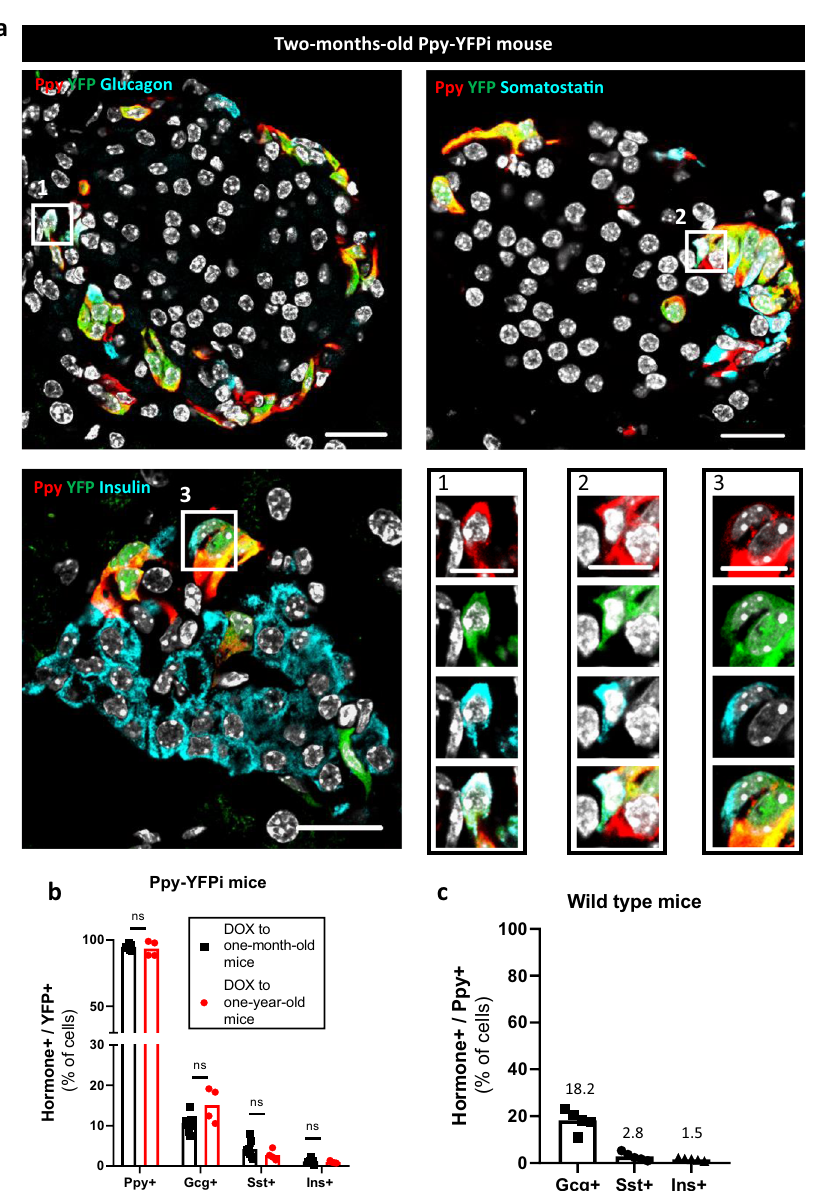
Fig. 3 Bihormonal islet cells co-express Ppy and another hormone in adult mice. a Immuno fl uorescence on pancreatic sections from 2-months-old Ppy- YFPi mice stained with Ppy (red) and YFP (green) in combination with: Glucagon (cyan, top left), Somatostatin (cyan, top right) or Insulin (cyan, bottom left). Bihormonal Ppy-Gcg (1), Ppy-Sst (2) and Ppy-Ins (3) cells are detected (bottom right). Scale bars: 20 μ m or 10 μ m (insets 1, 2, 3). b In young Ppy-YFPi mice ( n = 8 mice), 94.6%, 10.7%, 4.22% and 1.16% of YFP-traced cells are Ppy + , Gcg + , Sst + and Ins + , respectively (5411 YFP + Ppy + , 610 YFP + Gcg + , 225 YFP + Sst + and 81 YFP + Ins + out of 5714 YFP + cells scored). In aged Ppy-YFPi mice ( n = 4 mice), 93.4%, 19.0%, 2.8% and 1.0% of YFP-traced cells are Ppy + , Gcg + , Sst + and Ins + , respectively (2751 YFP + Ppy + , 418 YFP + Gcg + , 81 YFP + Sst + and 27 YFP + Ins + out of 5964 YFP + cells scored). Two- tailed Mann – Whitney test (ns p > 0.05; * p ≤ 0.05; ** p ≤ 0.01; *** p ≤ 0.001). c In adult wild-type mice ( n = 5 mice), 18.2%, 2.77% and 1.54% of Ppy + cells are Gcg + , Sst + and Ins + , respectively (535 YFP + Gcg + , 73 YFP + Sst + and 43 YFP + Ins + out of 2884 Ppy + cells scored). Data are presented as mean values ± s.e.m. Region of the pancreas: Ventral. See Source data are provided as Source Data fi le (Supplementary Table